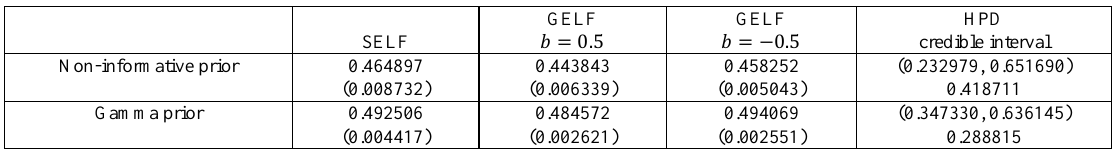
Table 3. Bayes estimates, expected loss functions (in brackets), HPD credible intervals (in brackets) with length for 𝜂 = 𝑃(𝑌 < 𝑋) using non-informative prior under squared error loss function (SELF) and Generalised entropy loss function (GELF) GELF GELF HPD SELF credible 𝑏 = 0.5 𝑏 = −0.5